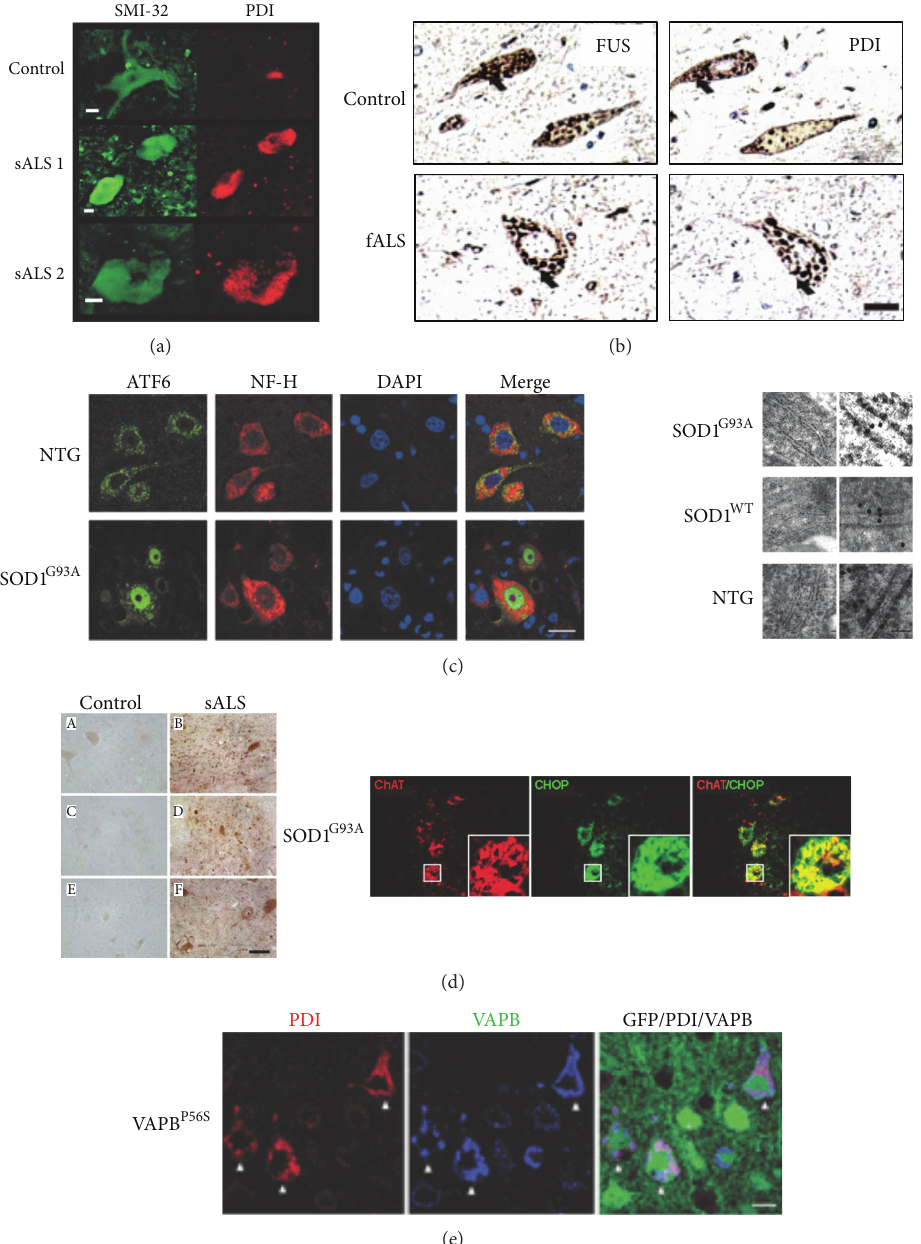
Figure1:UPRactivationinALShumansamplesandmousemodelsofthedisease.Severalexamplesofpublisheddataindicatingtheactivation of the UPR in SALS human samples and animal models. (a) Immunostaining of spinal cord motoneurons with the neurofilament marker SMI-32 showing PDIA1 (PDI) overexpression in samples from two sporadic ALS patients (sALS) compared with healthy subjects. Scale bar, 10 𝜇 m (from Atkin et al. [30]). (b) Immunohistochemistry of spinal cord section from a familial ALS patient (fALS) with a FUS mutation. The colocalization of FUS protein (left panel) and PDIA1 (PDI) protein (right panel) is indicated with black arrows. Scale bar, 40 𝜇 m (from Farg et al. [92]). (c) Left panel, immunodetection of the UPR sensor ATF6 (green), neurofilament (NF-H, red), and DAPI (blue) in spinal cord sections from SOD 1 G 93 A mutant mice and nontransgenic control animals (NTG). Scale bar, 20 𝜇 m. Right panel, SOD1 protein detection in ER lumen by immunoelectron microscopy in SOD 1 G 93 A mutant, SOD1 wild-type ( SOD 1 WT ) , and nontransgenic (NTG) mice. Scale bar, 50nm (from Kikuchi et al. [38]). (d) Left panel, CHOP positive cells detected in spinal cord sections from human sporadic ALS (sALS) patient. Control tissue in (A), (C), and (E). Pictures derived from cervical spinal cord ((A) and (B)), thoracic spinal cord ((C) and (D)), and lumbar spinal cord ((E) and (F)). Scale bars, 65 𝜇 m. In the right panel, immunolocalization of CHOP (green) in anti-ChAT (red) positive spinal cord motoneurons from SOD 1 G 93 A mutant mice. Scale bar: 40 𝜇 m. The areas with a box are shown at higher magnification. Scale bar 10 𝜇 m (from Ito et al. [33]). (e) Immunostaining of corticospinal motor neurons from 3-month-old VAPB P 56 S transgenic mice. Transgene detected with GFP (green), PDIA1 (PDI) (red staining), and VAPB (blue staining). Arrowheads show neurons with accumulation of PDI and VAPB. Scale bar: 20 𝜇 m (from Aliaga et al. [50]). Copyright authorization was obtained from each journal for all